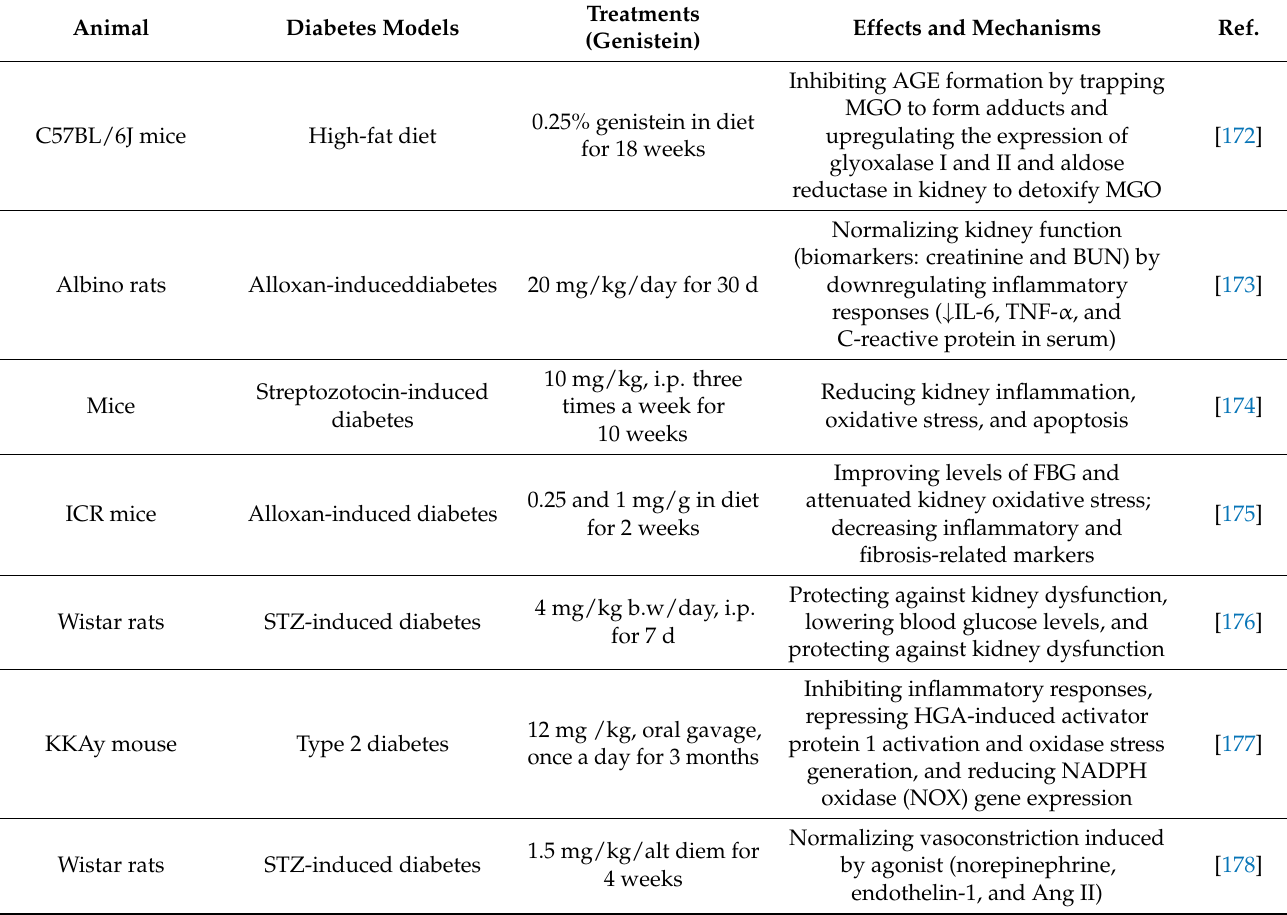
Table 4. The effects of genistein attenuating diabetic